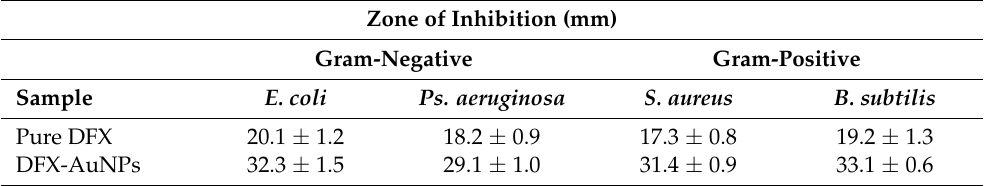
Table 1. Zone of inhibition obtained through agar well diffusion